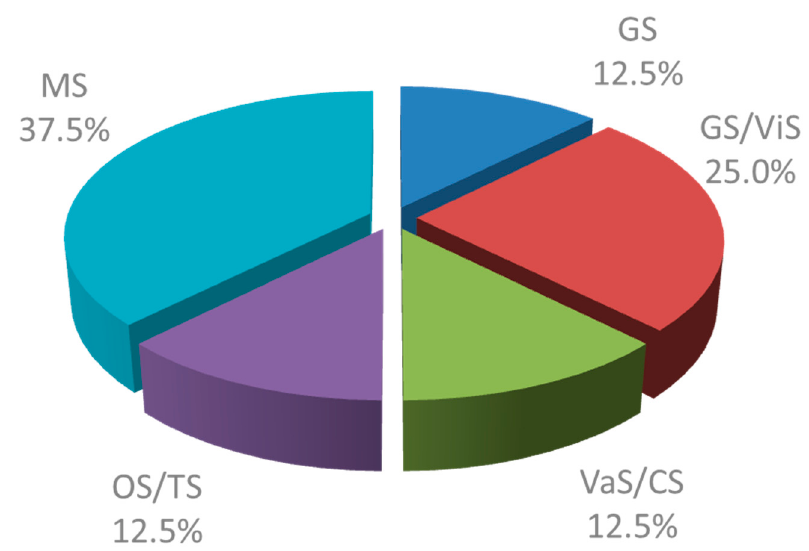
Figure 1. Presence of SOPs for SUP in surgical subspecialties in Mecklenburg West Pomerania, Germany GS: General surgery; GS/ViS: General andVisceral Surgery; VaS/CS: Vascular and cardiac surgery; OS/TS: Orthopedic and trauma surgery; MS: mixed surgical departments. Table 3. Routine SUP in the intensive care unit and the GHW of participating surgical departments according to the HoD response to the question: “Do of patients in the ICU/GHW receive SUP routinely?” ( n = 25). Departments with SOP